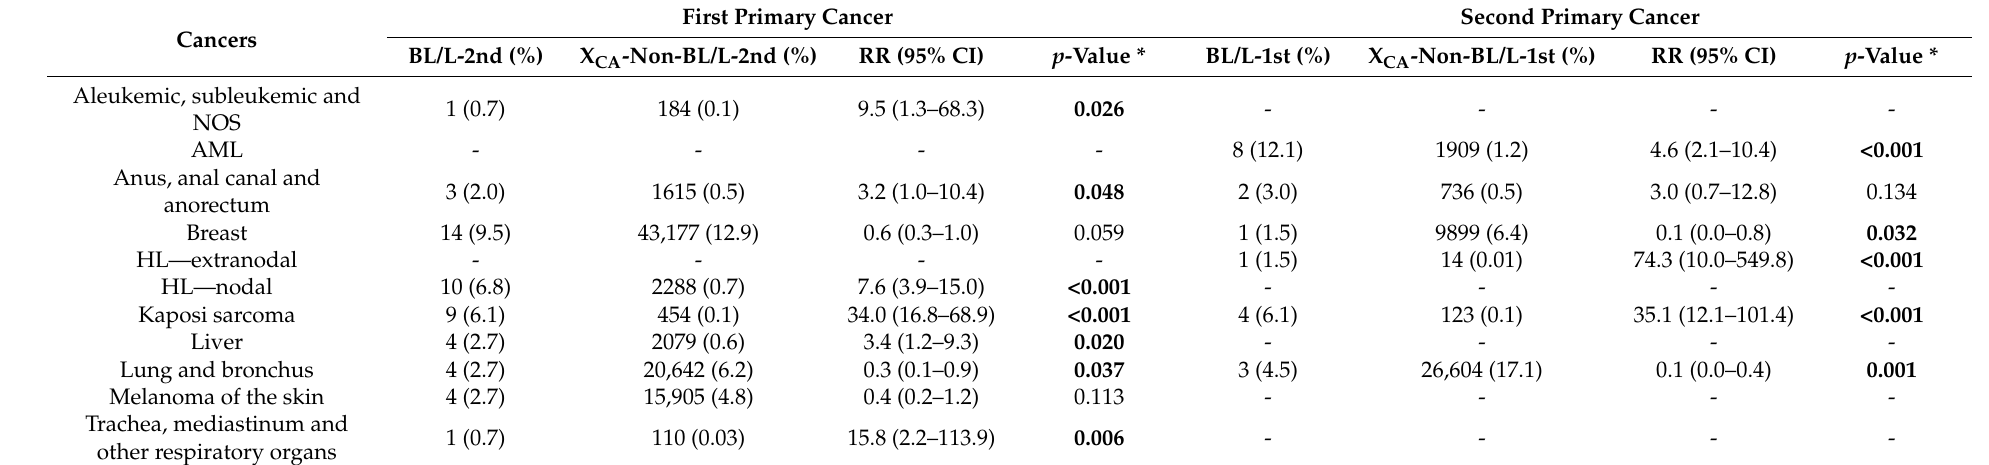
Table 3. Poisson regression final model of interrelated cancer risk on